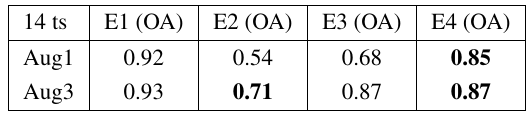
Table 5. SSL with 14 time steps: Overall accuracy (OA) with all data (E1); OA with 0% labels for 2018 (E2); with 5% labels (E3) and 10% for 2018 (E4).